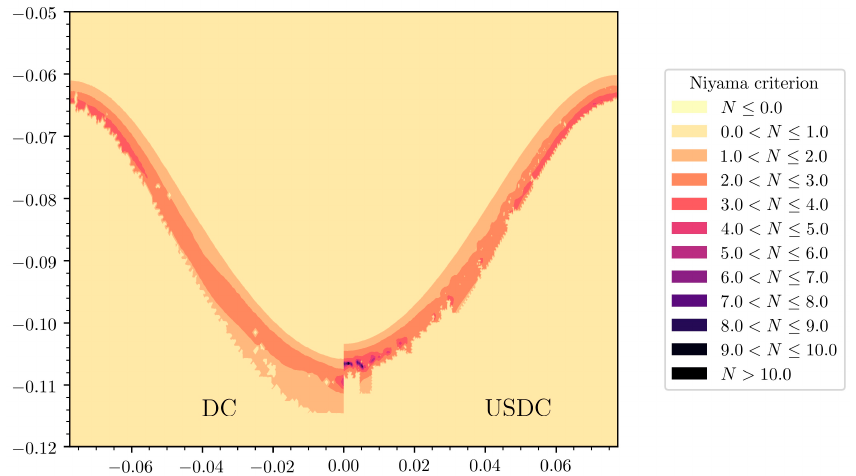
Figure 5. Comparison using the Niyama criterion between conventional DC casting (left) and ultrasonically assisted DC casting (right) using the casting conditions defined in [38]. The larger values upon sonication indicate an increased probability of porosity defects at the centre of the cast billet.